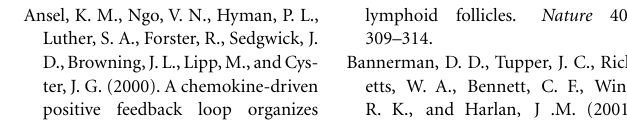
FIGURE 1 | Spectrum of antigen-specificT cell–EC interactions. (A) NaïveT cells immunologically ignore resting ECs which express MHC class I, but are MHC II low or MHC II − . (B) Effector CD8 + T cells can recognize cognate antigen on ECs leading to EC activation and may potentially damage the vascular bed. (C) Activated ECs upregulate expression of MHC II, adhesion molecules and ligands ofT cell co-inhibitory